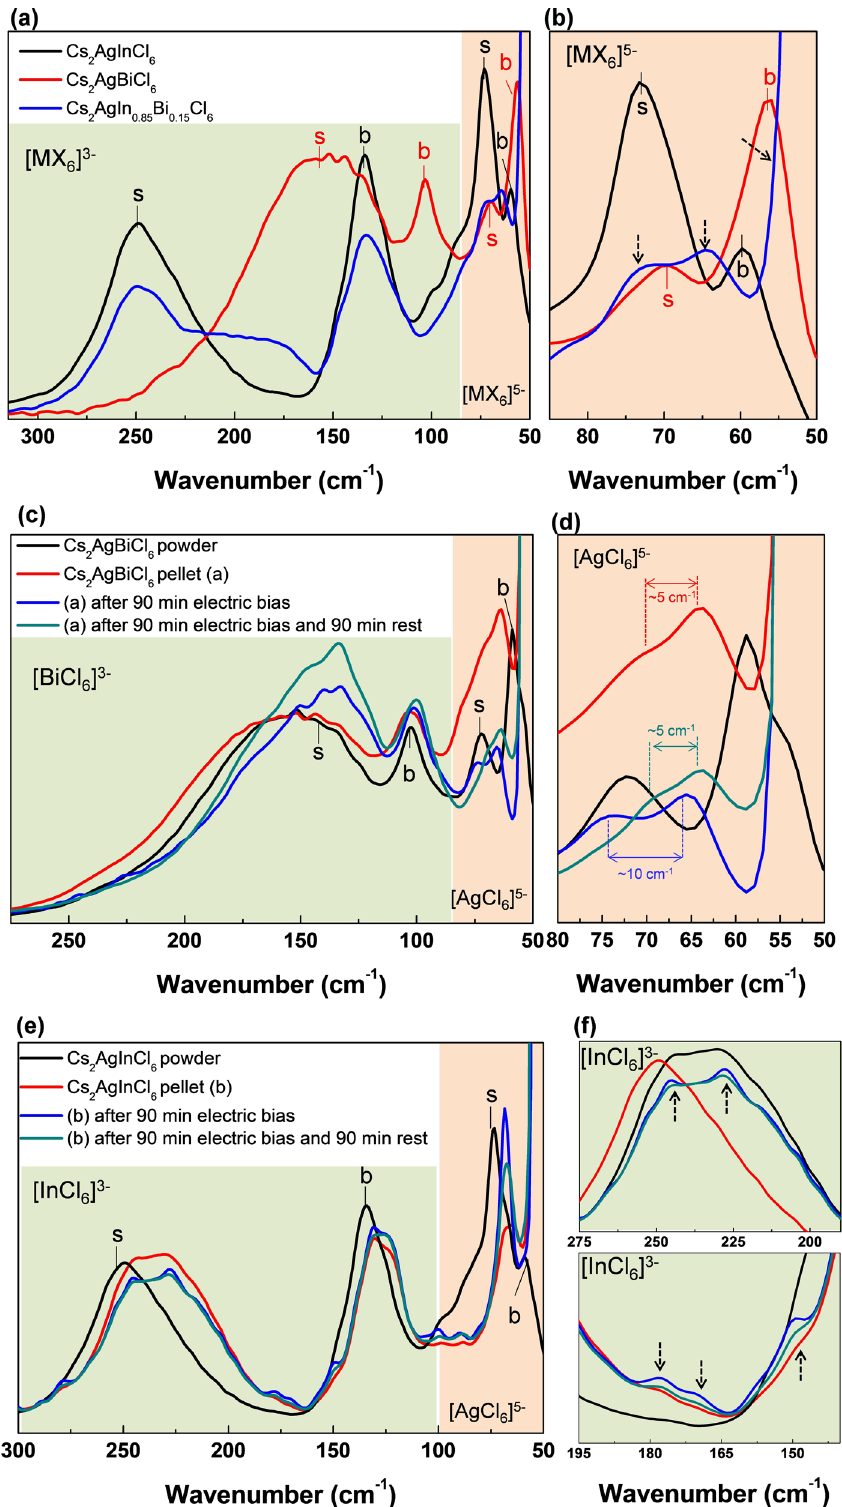
Fig. 9 FTIR spectra of halide double perovskites. a , b Cs 2 AgBiCl 6 , Cs 2 AgInCl 6 , and Cs 2 AgIn x Bi 1 − x Cl 6 powders. c , d The spectra of CABC powders and pellet before and after the application of electric bias. e , f The spectra of CAIC powders and pellet before and after the application of electric